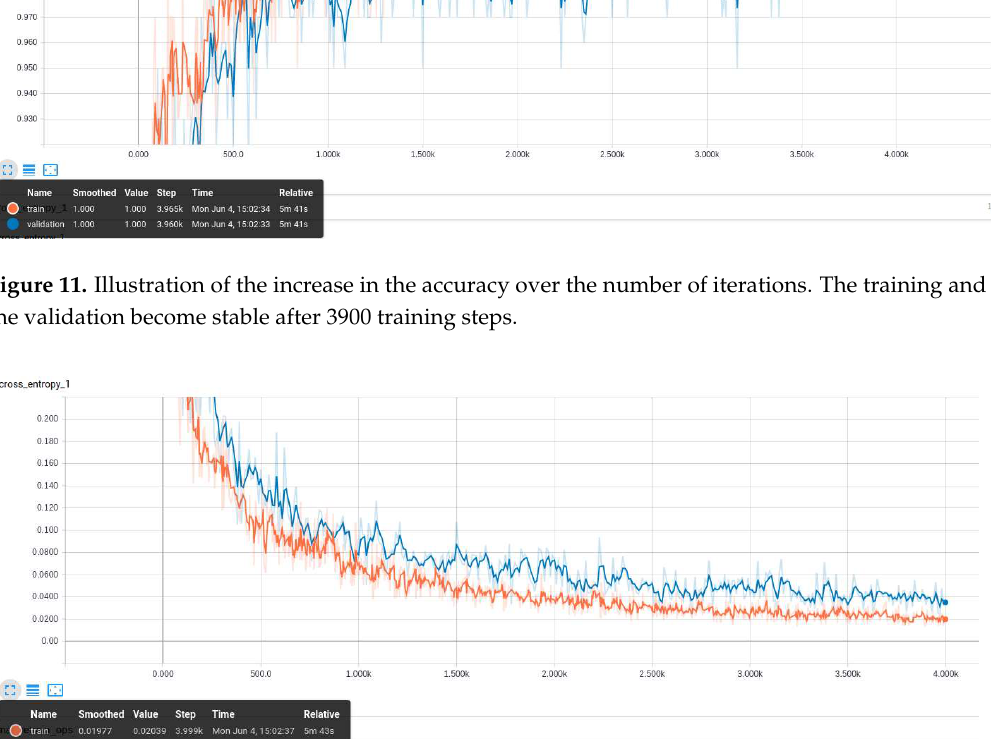
Figure 13. The spatial distribution of our (retrained InceptionV3) model extracted feature representation shows how well features are grouped. In Red, we see elements classified as Healthy (For Healthy Breast), and In Blue, we see features organized as Sick (For Sick Breast or Breast with Cancer).